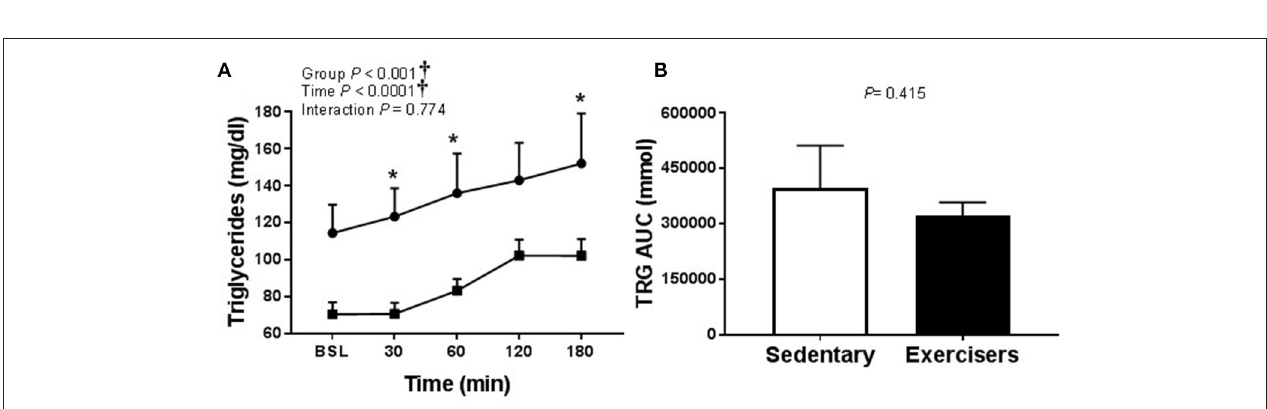
FIGURE 7 | Glucose homeostatic responses to a high fat mixed meal (HFMM) at baseline, and 30, 60, 120, and 180min post-ingestion in sedentary participants ( n = 11) and exercisers ( n = 33). (A) Blood glucose response over 180min. (B) Serum insulin levels over 180min. (C) Matsuda insulin sensitivity index (ISI) and (D) Glucose are under the curve (AUC) over the 180min postprandial period. All data presented as mean ± SEM. † Indicates significant main or interaction effect ( P < 0.05). *Indicates significant difference between sedentary participants and exercisers (adjusted P < 0.05 after Sidak-Bonferroni adjustment).